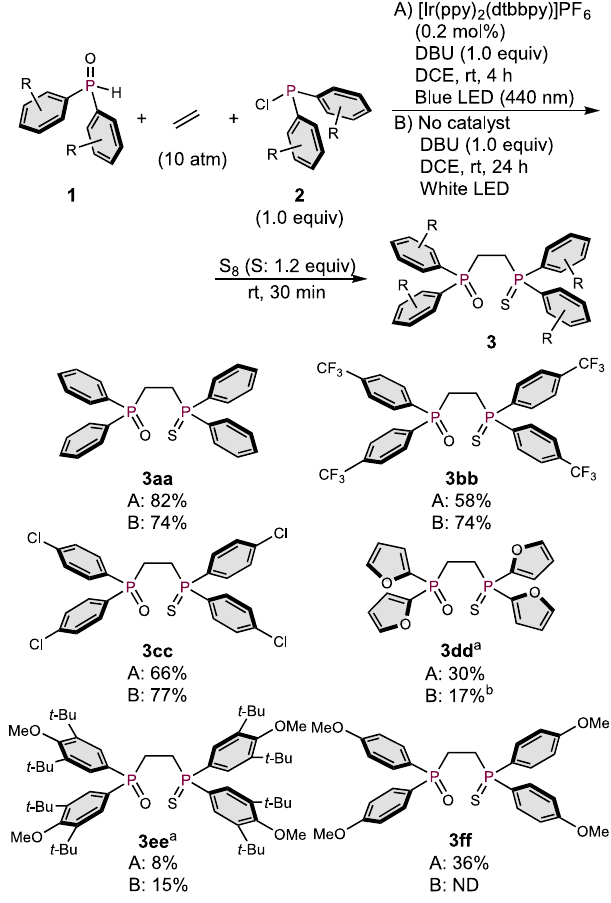
Fig. 3 | Scope of symmetric DPPE derivatives. Conditions A: Ir catalyst (0.001mmol), 1 (0.5mmol), 2 (0.5mmol),DBU (0.5mmol), ethylene (10atm), DCE (1.5mL), and two blue LEDs. Conditions B: 1 (0.5mmol), 2 (0.5mmol), DBU (0.5mmol), ethylene (10atm), DCE (1.5mL), and two white LEDs. a Reaction scale: 0.25mmol. b Only one white LED was employed because two LEDs did not provide the